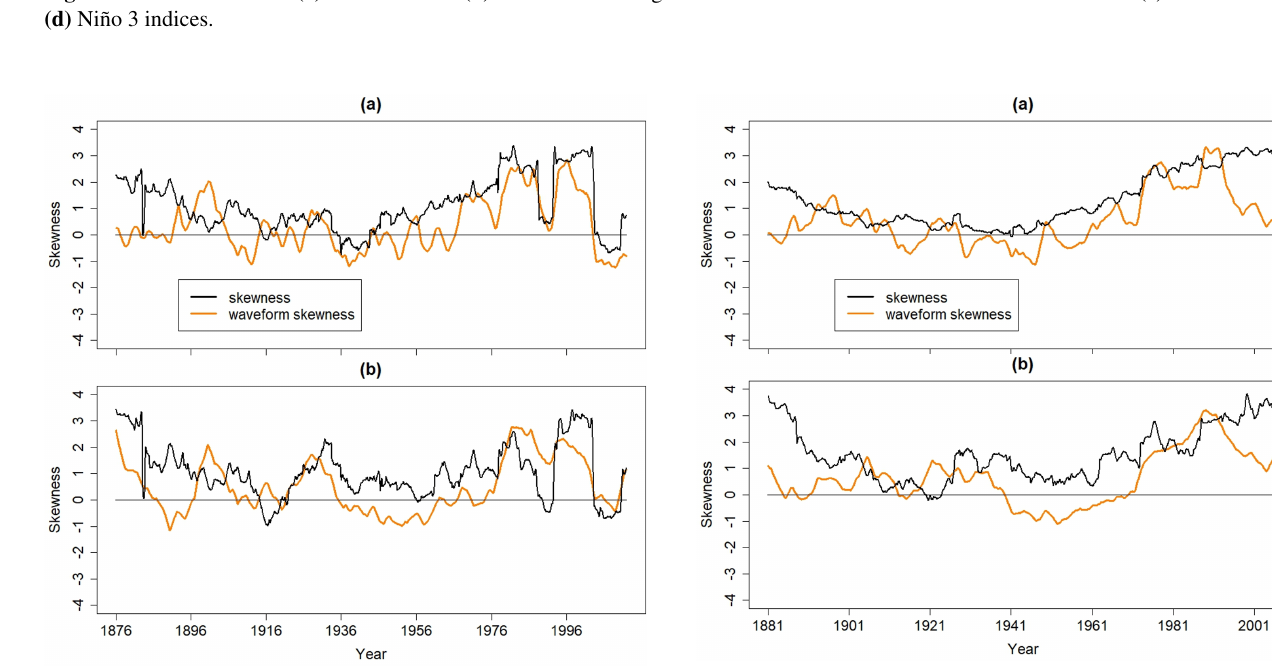
Figure 6. 10-year sliding skewness and waveform skewness time series corresponding to the (a) Niño 1 + 2 and (b) Niño 3 indices.